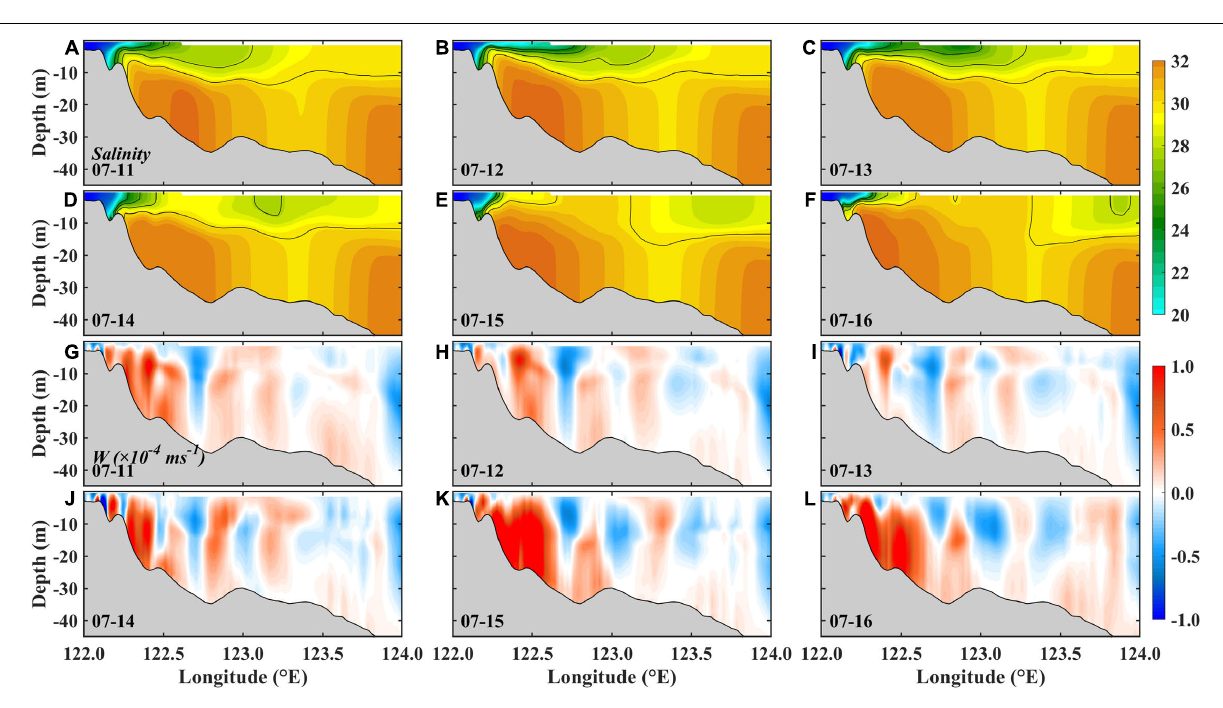
from the CRE to the Zhejiang coast but slightly decreased offshore, and the difference between Exp1 and Exp2 is less than 3 psu (not